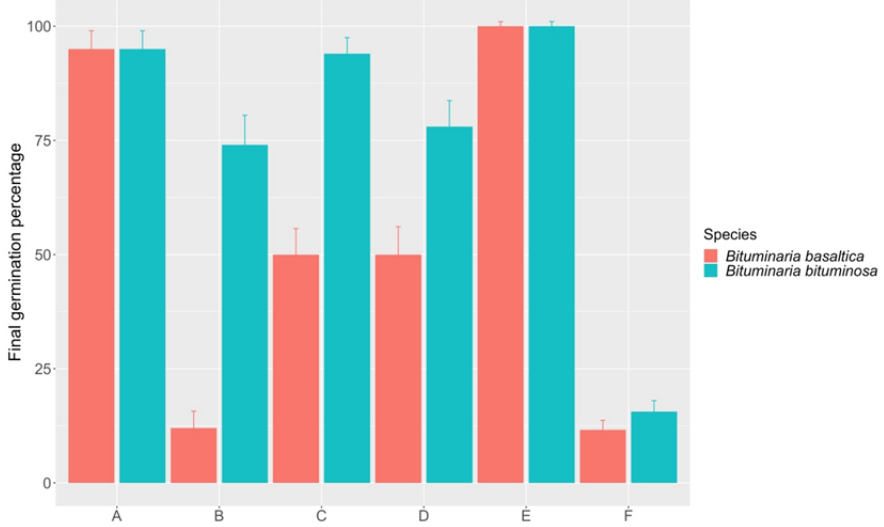
Figure 8. Summary of the most e ff ective dormancy-breaking treatments. A: chemical treatment (50 min immersion time) and incubation temperature at 25 / 20 ◦ C ( B. basaltica ) and 20 / 15 ◦ C ( B. bituminosa ); B: thermal treatment at 100 ◦ C (2 min immersion time) and incubation temperature at 20 / 15 ◦ C ( B. basaltica ) and 25 / 20 ◦ C ( B. bituminosa ); C: thermal treatment at 70 ◦ C (6 min immersion time for B. basaltica and 10 min for B. bituminosa ) and incubation temperature at 25 ◦ C (both species); D: thermal treatment at 100 ◦ C with gradual cooling (5 min immersion time for B. basaltica and 30 min for B. bituminosa ) and incubation temperature at 25 / 20 ◦ C for both species; E: mechanical treatment; F: untreated. Vertical bars represent standard